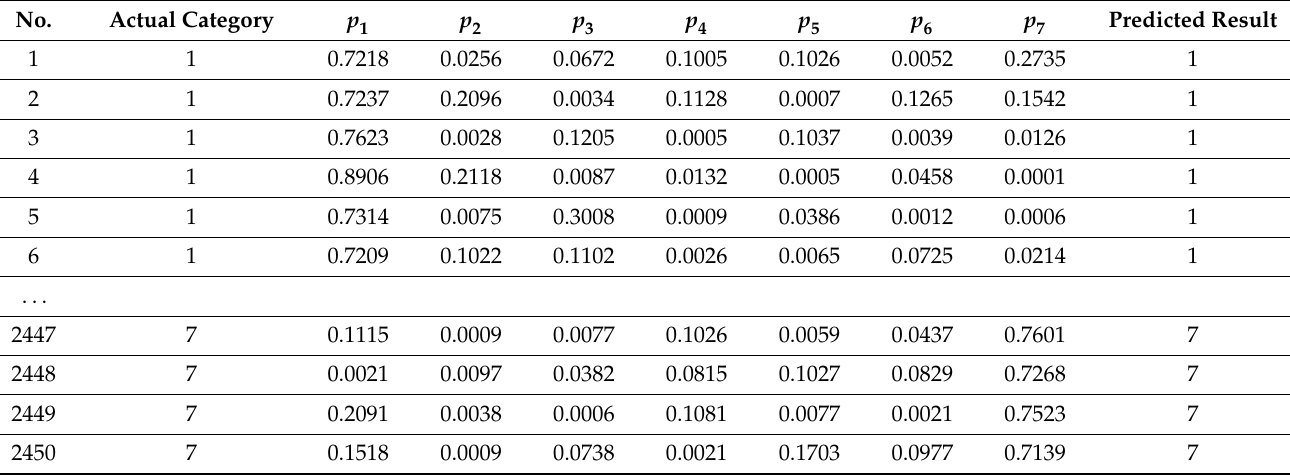
Table 3. The probability output vector of the proposed